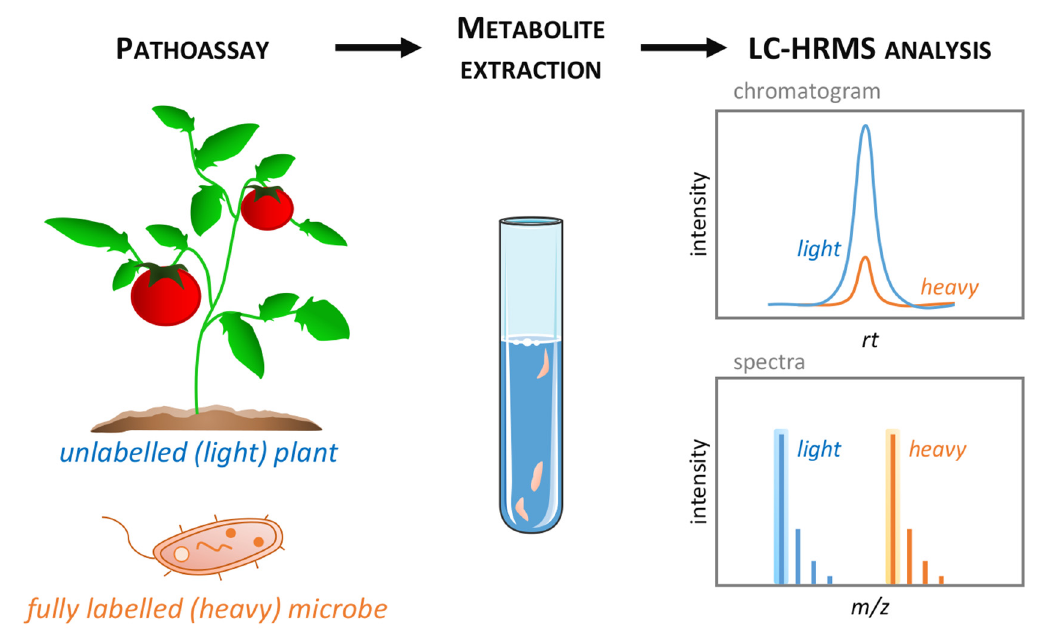
Figure 3. LC-HRMS discrimination between native and labelled metabolites. Unlabelled (light) plant tissues (e.g., leaves) are inoculated with fully labelled (heavy) pathogenic microbe (e.g., 13 C isotopically labelled bacteria) then sampled at the appropriate time point for metabolome analysis (left). The resulting metabolite extracts thus contains a mixture of light and heavy biochemical (middle) that could be discriminated by LC-HRMS technique (right). Light and heavy metabolites display similar retention time (RT) on the LC-HRMS chromatogram, but natural isotope clusters of light and heavy forms are well separated on the mass spectra.